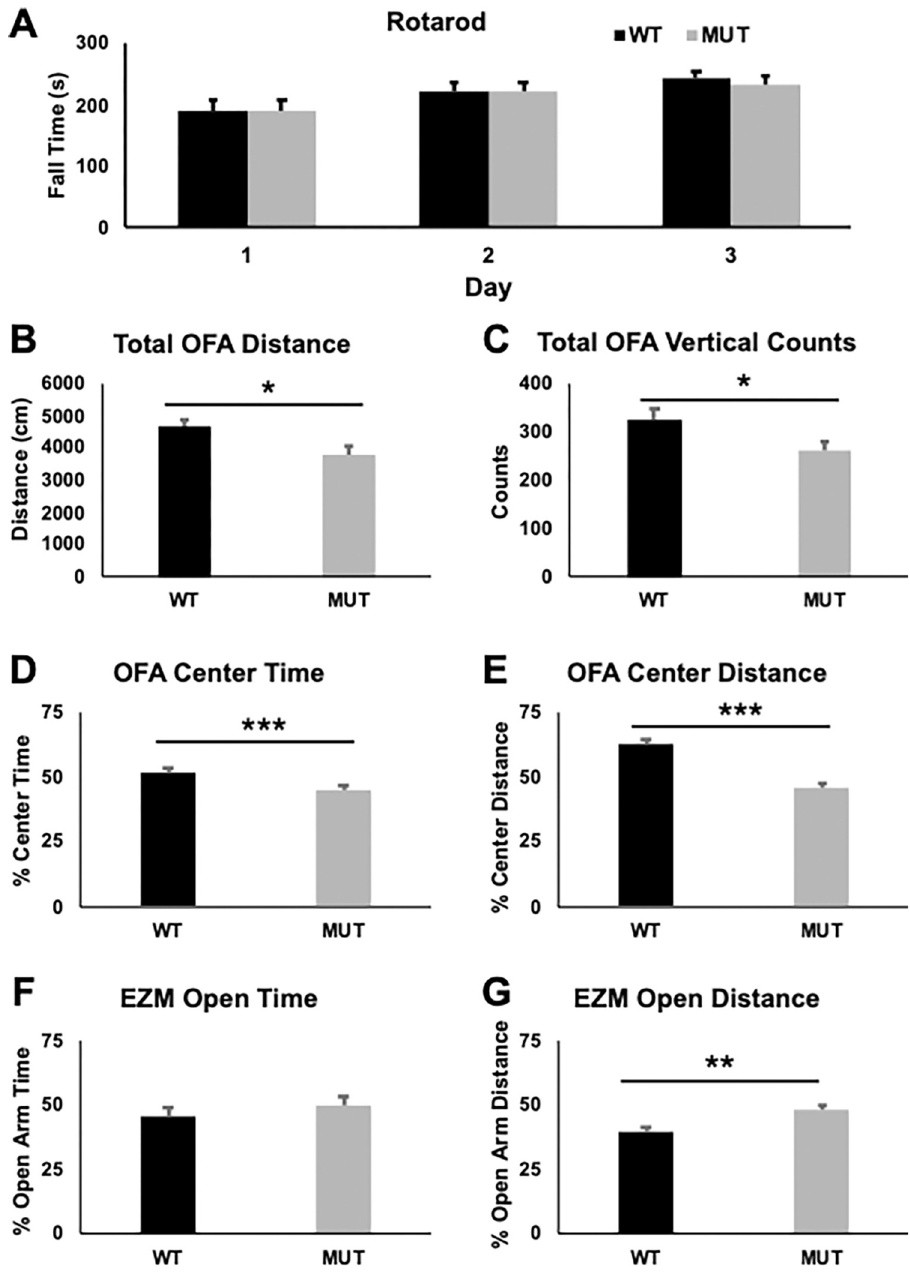
Fig 2. Analysis of motor function and anxiety in FoxG1 MUT/WT mice. A ) Foxg1 MUT/WT mice (MUT) do not show any changes on the accelerating rotating rod task compared to wild-type (WT) littermate controls (10 weeks old, n = 15 for each genotype). B-E: Open Field Assay (OFA, 8–11 weeks, WT n = 26, MUT n = 31). MUT animals have decreased overall distance traveled ( B , F[1,54] = 7.885, p = 0.007, corrected p = 0.037, η 2 = 0.127) and vertical counts ( C , F[1,54] = 6.592, p = 0.012, corrected p = 0.040, η 2 = 1.09). MUT animals spend less percentage time in center area ( D , F[1,54] = 6.991, p = 0.011, corrected p = 0.046, η 2 = 0.115) and travel less percentage distance traveled in the center area ( E , F[1,54] = 53.193, p < 0.001, corrected p < 0.001, η 2 = 0.496) in OFA. F-G: Elevated Zero Maze (EZM, 20wks, WT n = 11, MUT = 14). MUT animals did not show any difference in the percent time spent in the open arm ( F, F [1,22] = 1.027, p = 0.322, corrected p = 0.446) but traveled more percentage distance in the open arm ( G , F[1,22] = 9.838, p = 0.005, corrected p = 0029, η 2 = 0.322). Uncorrected p-values: � p < 0.05, � p < 0.01, ��� P < 0.001.